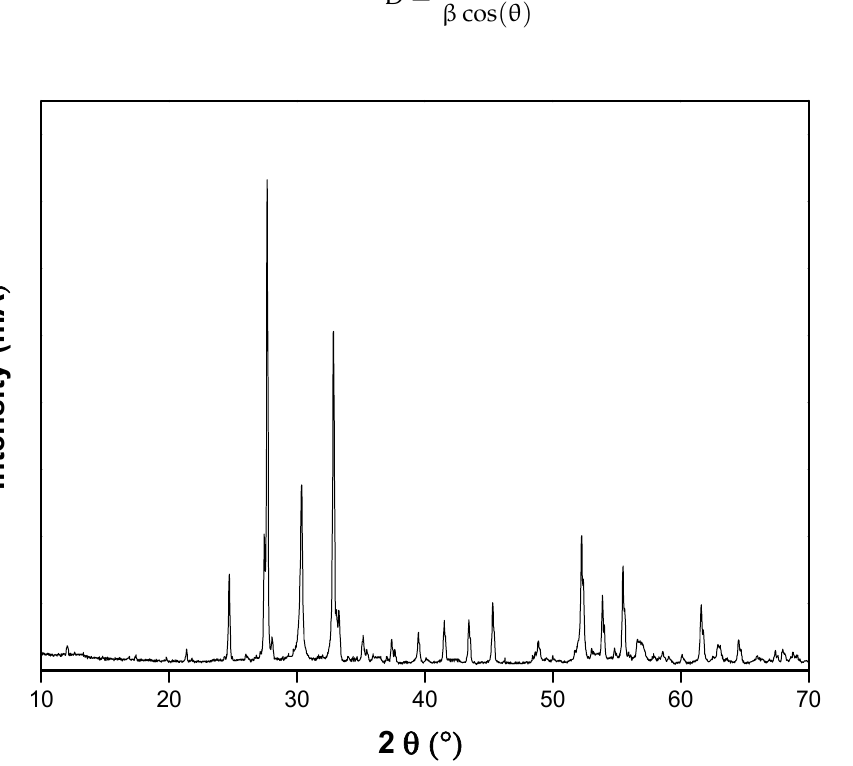
Figure 1. XRD diffractogram of ZnBi 2 O 4 calcined at 600 °C. D is the average crystallite size of the phase under examination in nanometers, K